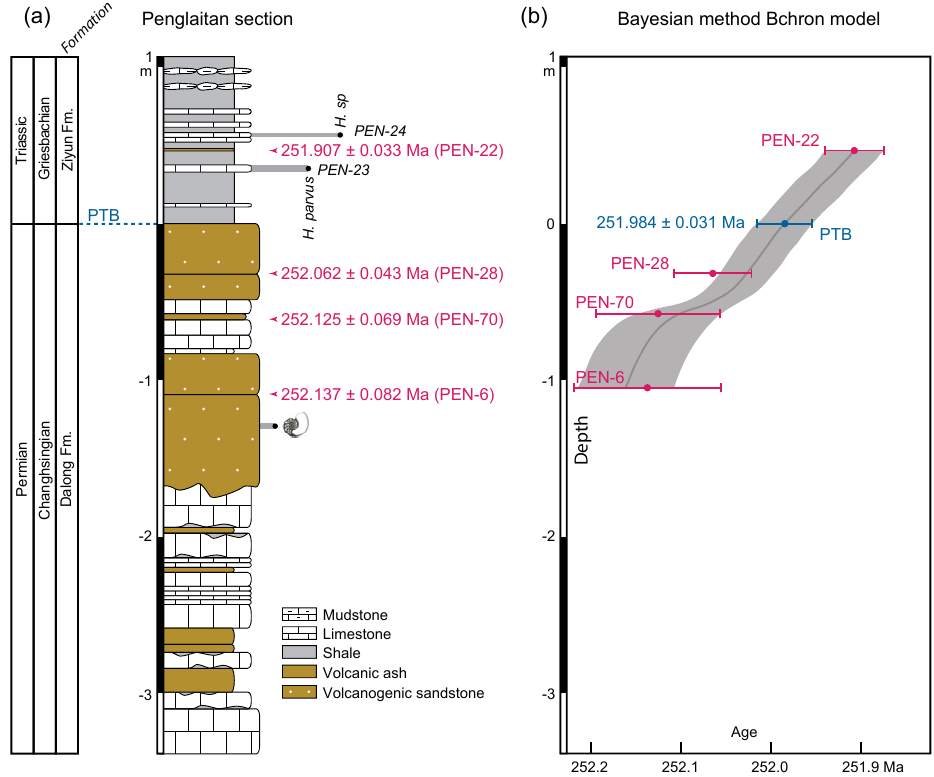
Figure 3. Stratigraphy, geochronology and Bayesian age–depth modeling for the Penglaitan section from late Changhsingian to Griesbachian. (a) Weighted mean 206 Pb / 238 U dates of the volcanic ash beds and volcanogenic sandstones are given in Ma. U-Pb data of PEN-28 and PEN-22 are taken from Baresel et al. (2016). Investigated conodont samples (PEN-23 and PEN-24; see also Sect. S5) and first occurrence of Triassic conodonts are shown in their stratigraphic positions. A poorly preserved Permian nautiloid is indicated in its stratigraphic position ca. 1.3m below the Permian–Triassic boundary (PTB). (b) The rescaled Bayesian Bchron age–depth model is presented with its median (middle grey line) and its associated 95% confidence interval (grey area). Radioisotopic dates together with their uncertainty (red horizontal bars) are presented as 206 Pb / 238 U weighted mean dates of the dated volcanic ash beds in their stratigraphic positions. Predicted date for the PTB is calculated with its associated uncertainty using the rescaled Bayesian Bchron age–depth model assuming stratigraphic